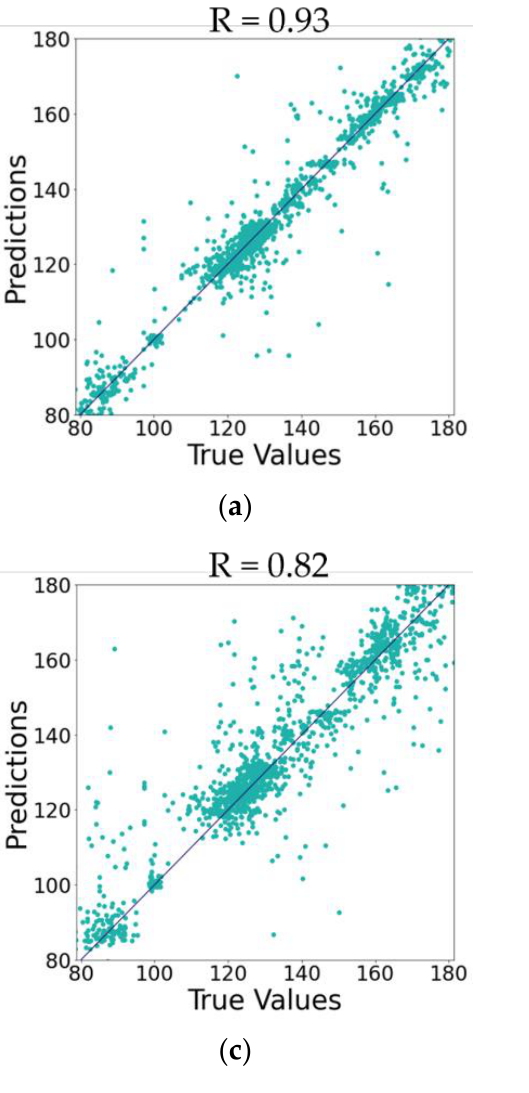
Figure 8. Ground-Truth Graph for SBP True Values vs. Predictions of Single-stage Models (trained on commonly used features set) and Multi-stage Models (trained on proposed features set). ( a ) For Single-Stage LSTM. ( b ) For Multi-Stage LSTM. ( c ) For Single-Stage ANN. ( d ) For Multi-Stage ANN.